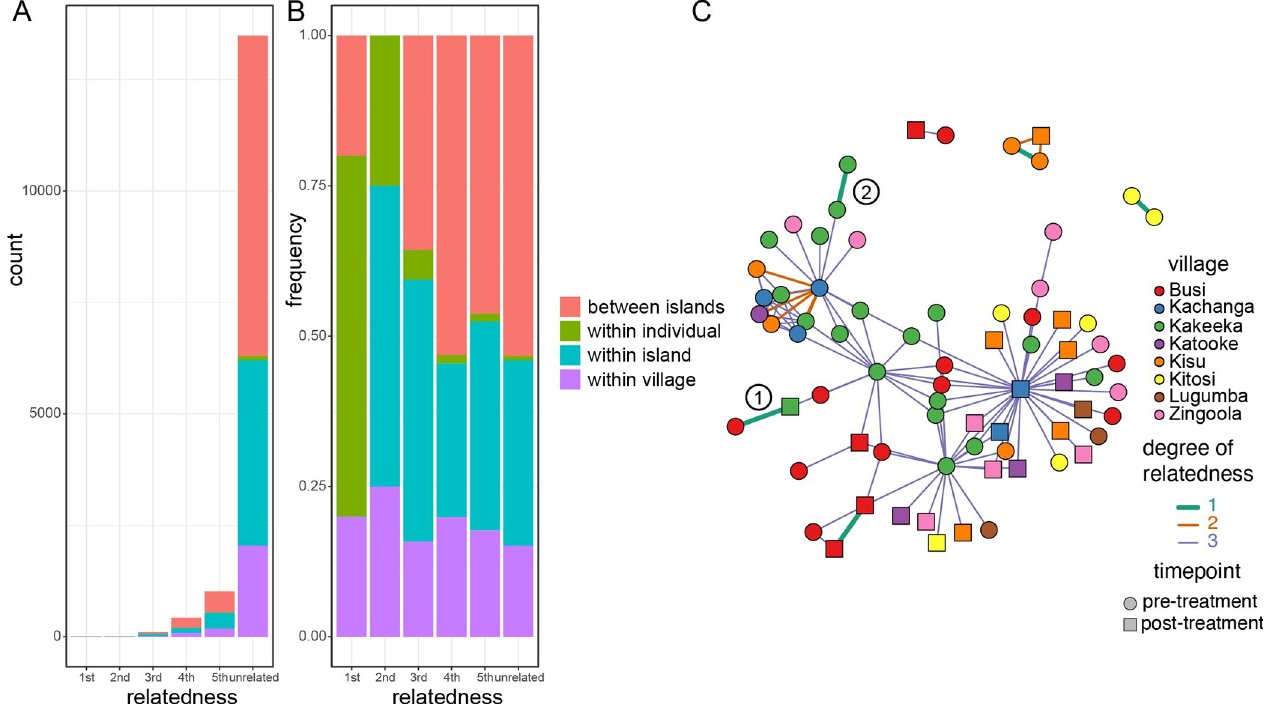
Fig 3. Patterns of relatedness inferred from pairwise rare allele sharing. (A) Number and (B) proportion of pairs of miracidia showing each degree of relatedness for miracidia sampled from the same individuals, villages or islands and for those on different islands. (C) Network representation of 1st, 2nd and 3rd degree relatedness. Vertices represent individual miracidia sampled, coloured by village and with a circle for samples taken pre-treatment and square for post-treatment samples. Edges join vertices inferred to share 1st, 2nd or 3rd degree relatedness, as indicated by both the width and colour of each edge. Numerical labels indicate two 1 st degree relationships discussed in the